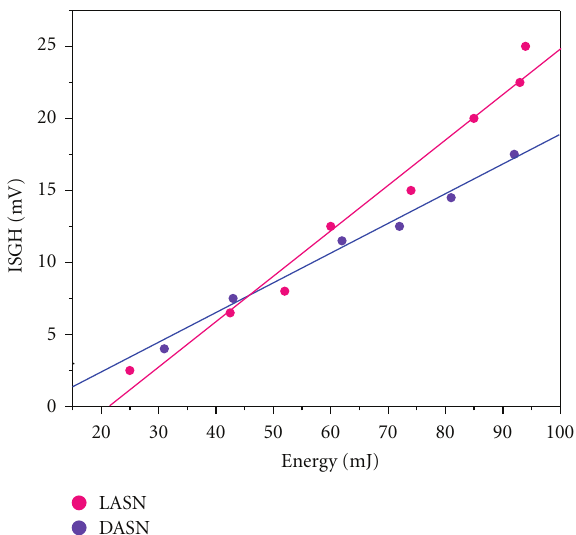
Figure 6: Quadratic fit for the SHG intensity as function of the beam